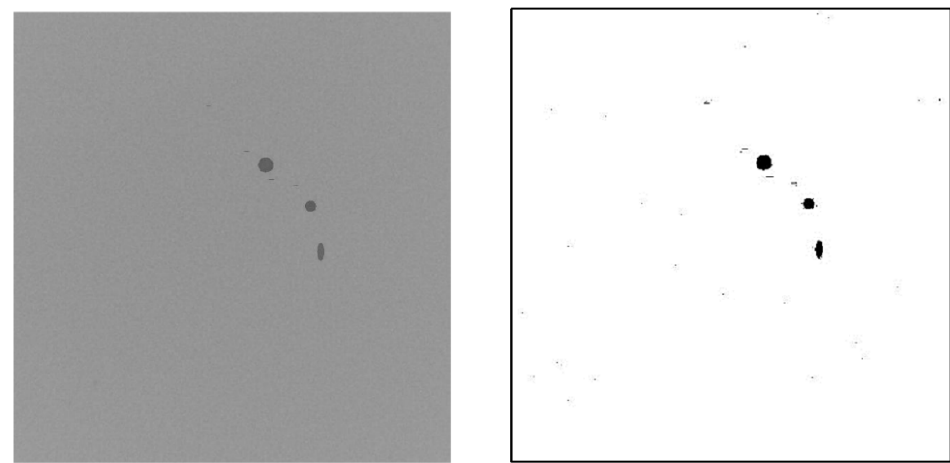
Figure 21. First version of artificial image ( Left ) vs. binarized artificial image ( Right ). As can be seen in the figure, there are tiny undesired black spots in different positions in the binarized image, and the undesired spots also appear in slices with no pores, as shown in the following Figure 22.